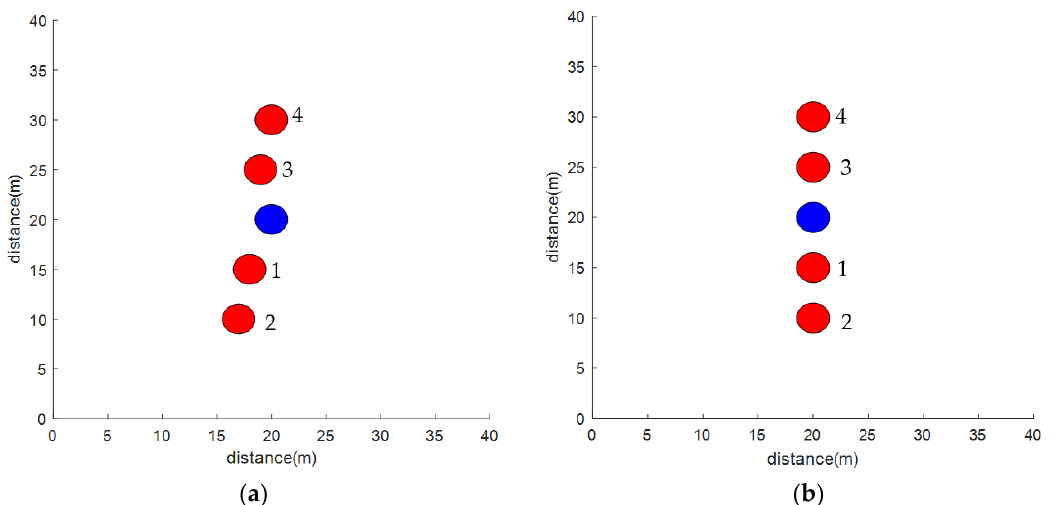
Figure 11. Initial position and expected formation of each vehicle in the UGVs fleet. ( a ) indicates initial positions of the vehicles and ( b ) indicates the expected formation of the fleet. The leader moves according to a pre-defined S-shaped route. Figure 12 below demonstrates the overall trajectory of the fleet.